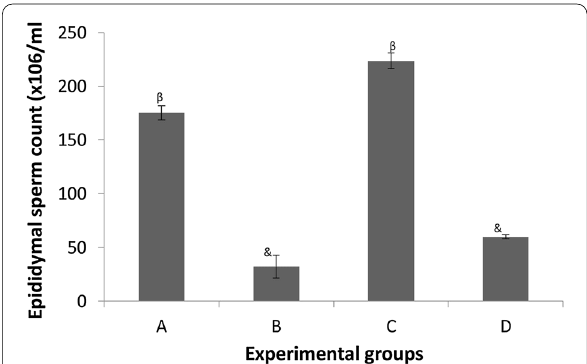
Fig. 1 A graph showing the mean epididymal sperm counts of rats from the experimental Group A (control), Group B (3 mg/kg CdCl 2 ), Group C (500 mg/kg TVE) and Group D (3 mg/kg CdCl 2 kg TVE). The values are expressed as mean of significance was set at p significantly